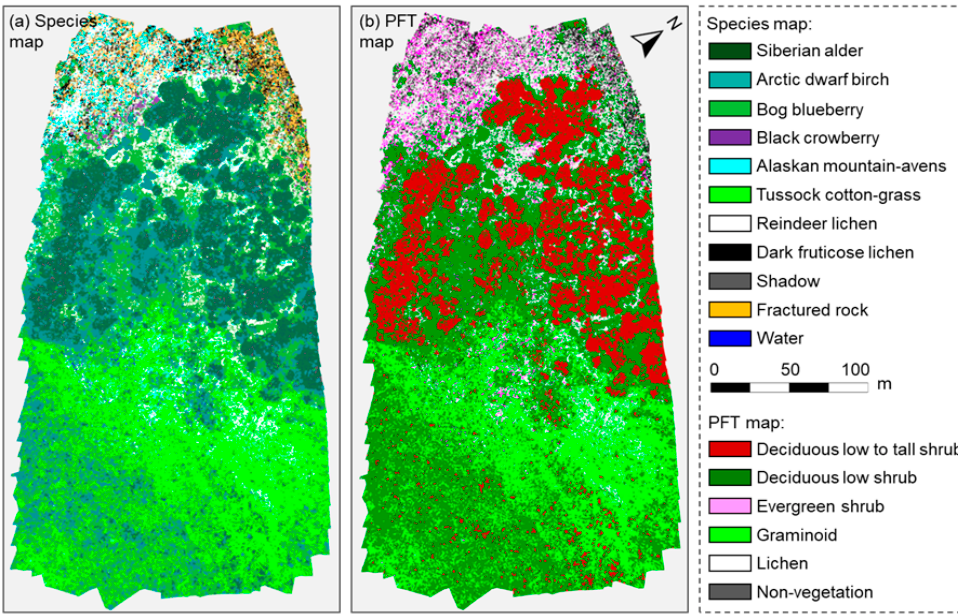
Figure 5. Vegetation mapping result using an object-based classification. ( a ) Species-level classification result, including eight species classes and three non-vegetation classes. ( b ) Species were merged into PFTs to create the PFT-level map. Table 3. Confusion matrix for species-level classification accuracy assessment. The diagonal cells (highlighted by bold text) correspond to reference samples that were correctly classified.